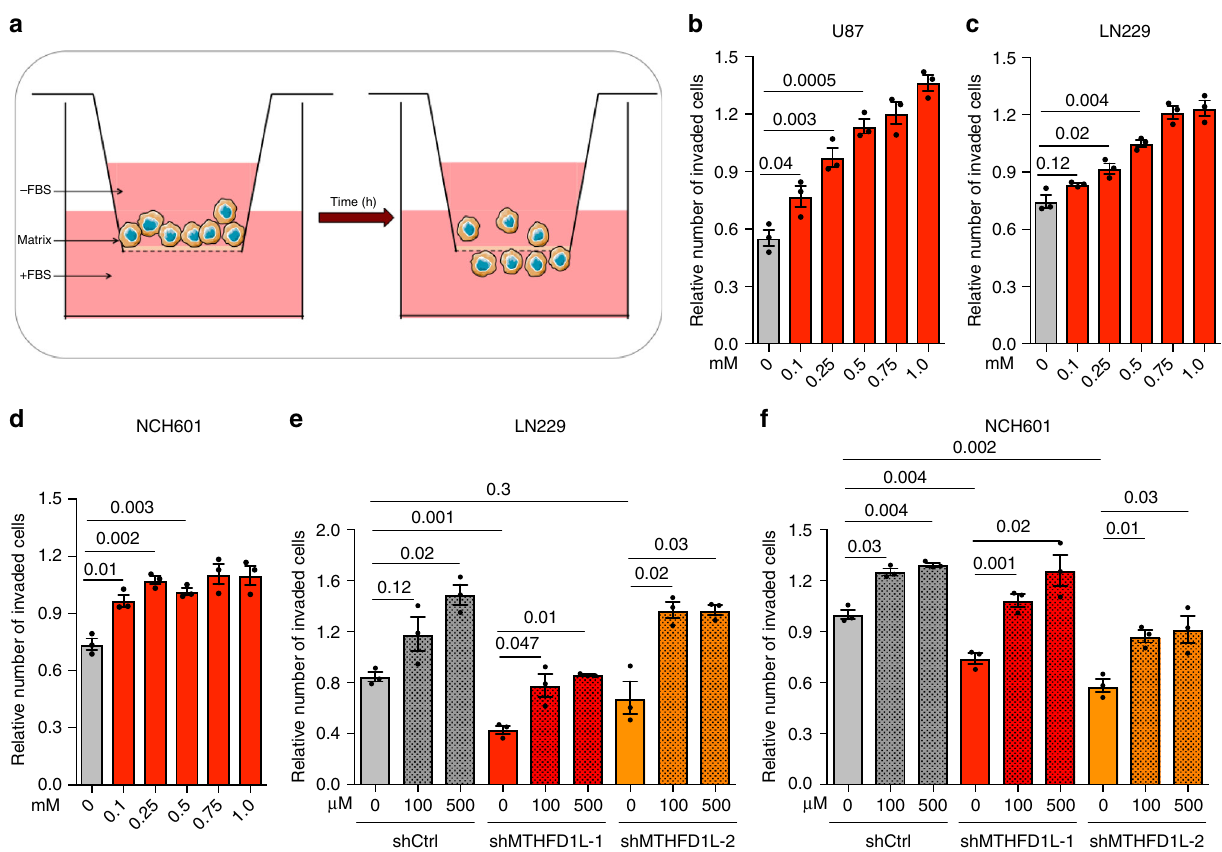
Fig. 6 Formate over fl ow promotes cancer cell invasion in GBM. a Cartoon illustrating the experimental setup to analyze cancer cell invasion using coated Boyden chambers. b – d Addition of extracellular sodium formate increases invasiveness in a concentration dependent manner in b U87, c LN229 and, d NCH601 cells. e , f Reduced invasiveness by MTHFD1L knockdown can be rescued with extracellular formate in e LN229 and f NCH601 cells. Each dot indicates one independent experiment ( n = 3). Error bars indicate s.e.m. p -values are calculated using an unpaired t -test with Welch ’ s